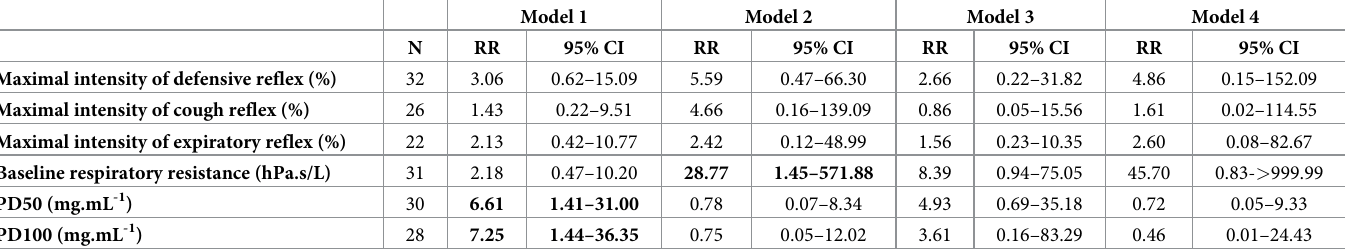
Table 4. Associations between exposures (farm vs control), intensity of respiratory responses induced by mechanical stimulation, and respiratory resistance before and after methacholine